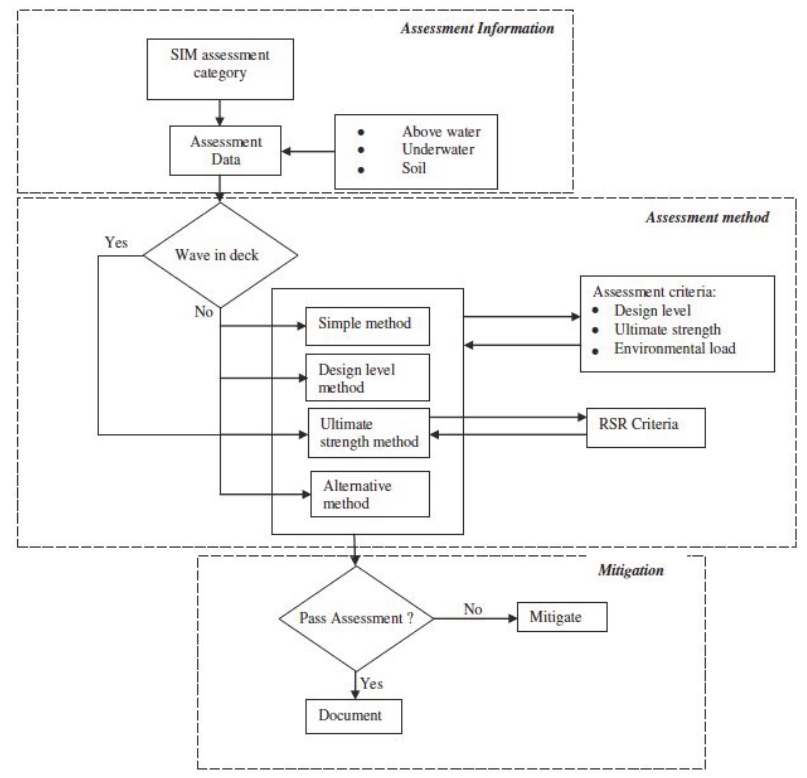
Figure 7. Metocean data assessment process for risk-based inspection technique